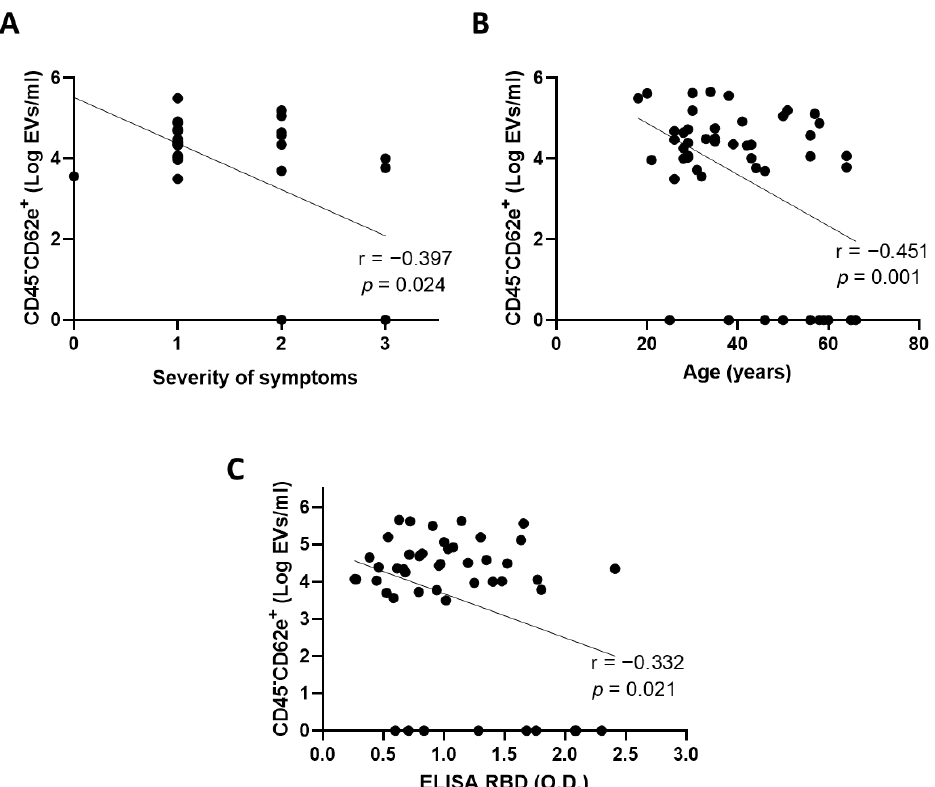
Figure 3. Circulating CD45 - CD62e + EVs and clinical parameters. The correlation between CD45 - CD62e + EVs and ( A ) the severity of symptoms of donors, ( B ) the age of donors,